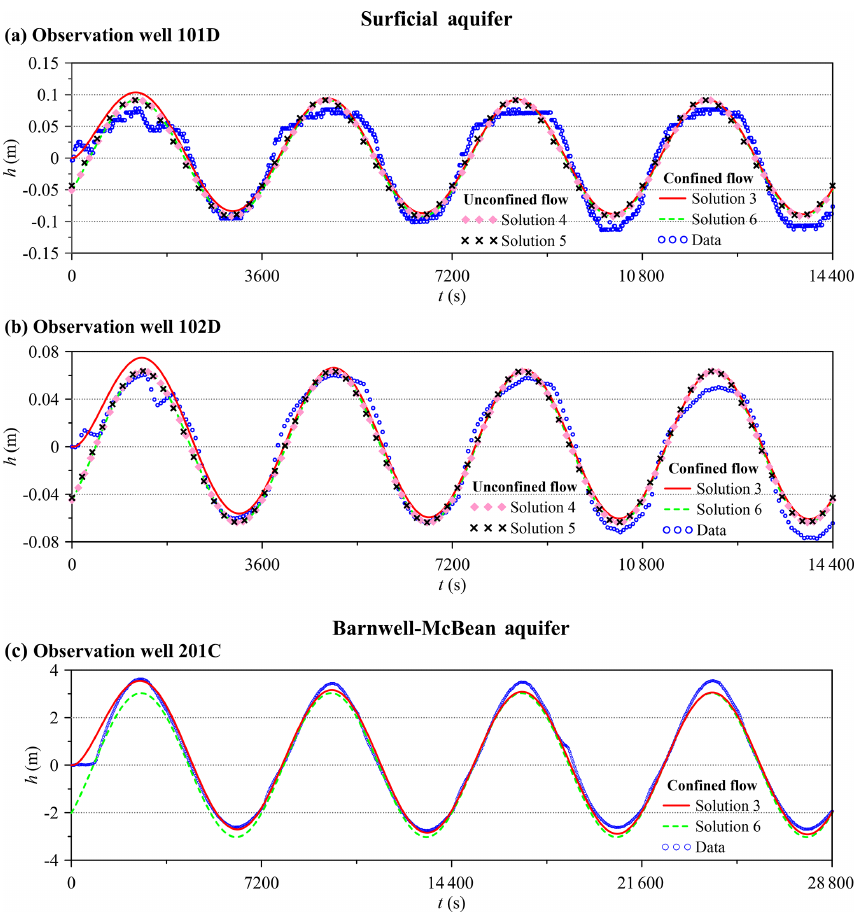
Figure 7. Comparison of field observation data with head fluctuations predicted by the present solution. Solutions 3 and 6 represent transient and PSS confined flows, respectively. PSS Solutions 4 and 5 stand for DGD and IGD conditions, respectively.